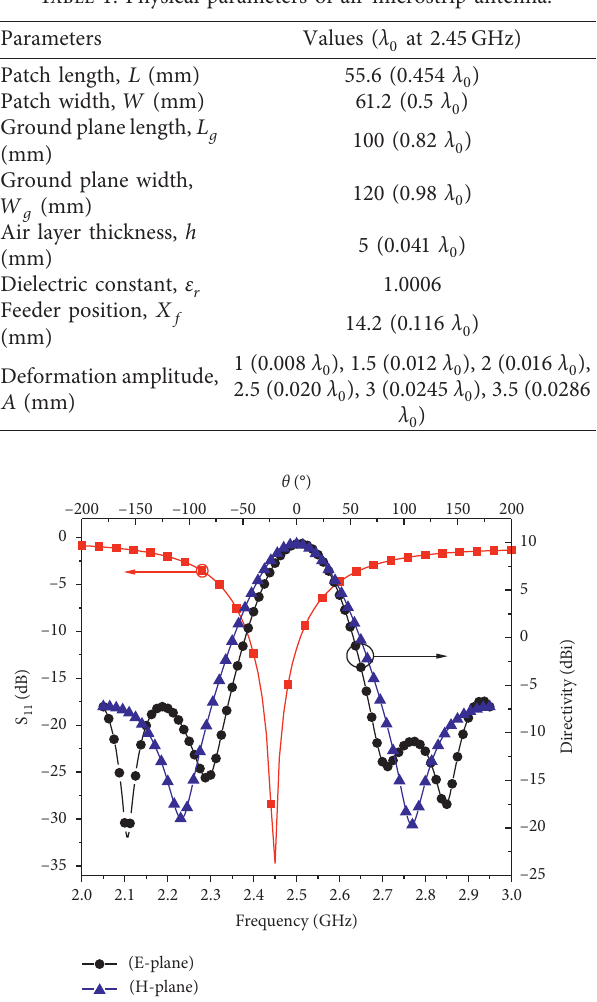
Figure 2: Simulation results of electrical performance of the air microstrip